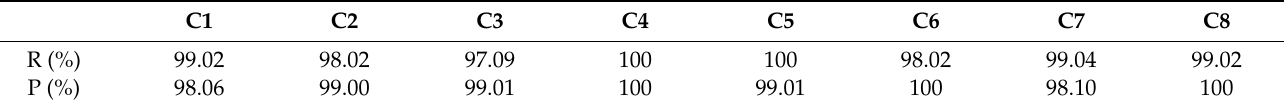
Table 3. The prediction result of the MobileNetV3.